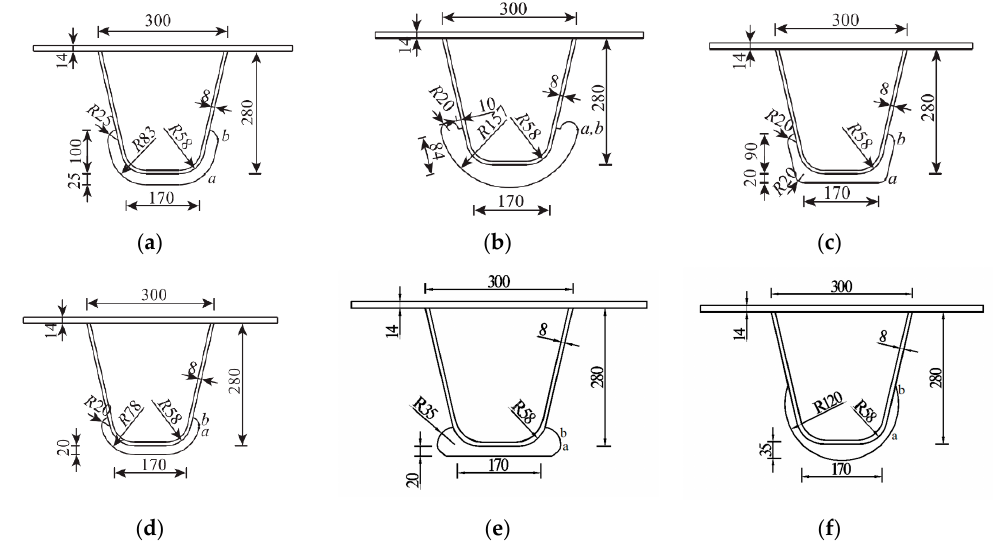
Figure 1. Representative diaphragm cutouts including ( a ) Type I: highway cutout in Eurocode 3, ( b ) Type II: railway cutout in Eurocode 3, ( c ) Type III: AASHTO cutout, ( d ) Type IV: Japanese standard cutout, ( e ) Type V: cutout used in Williamsburg bridge, ( f ) Type VI: large radius cutout.